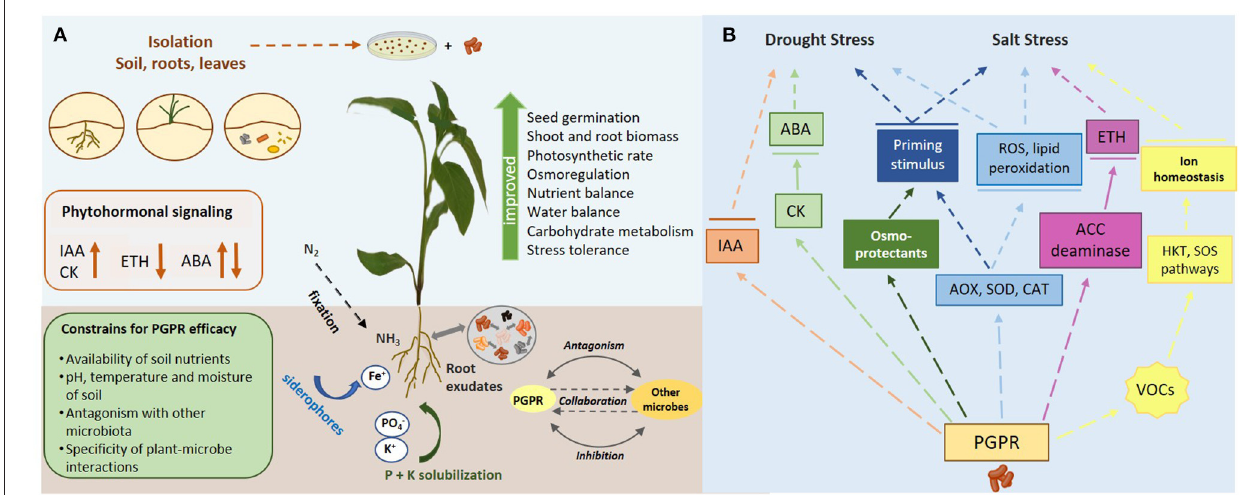
FIGURE 1 | (A) An overview of diverse PGP traits affecting plant growth and stress tolerance. (B) A diagrammatic representation of the mechanisms underlying PGPR-mediated stress tolerance against drought and salt stress.